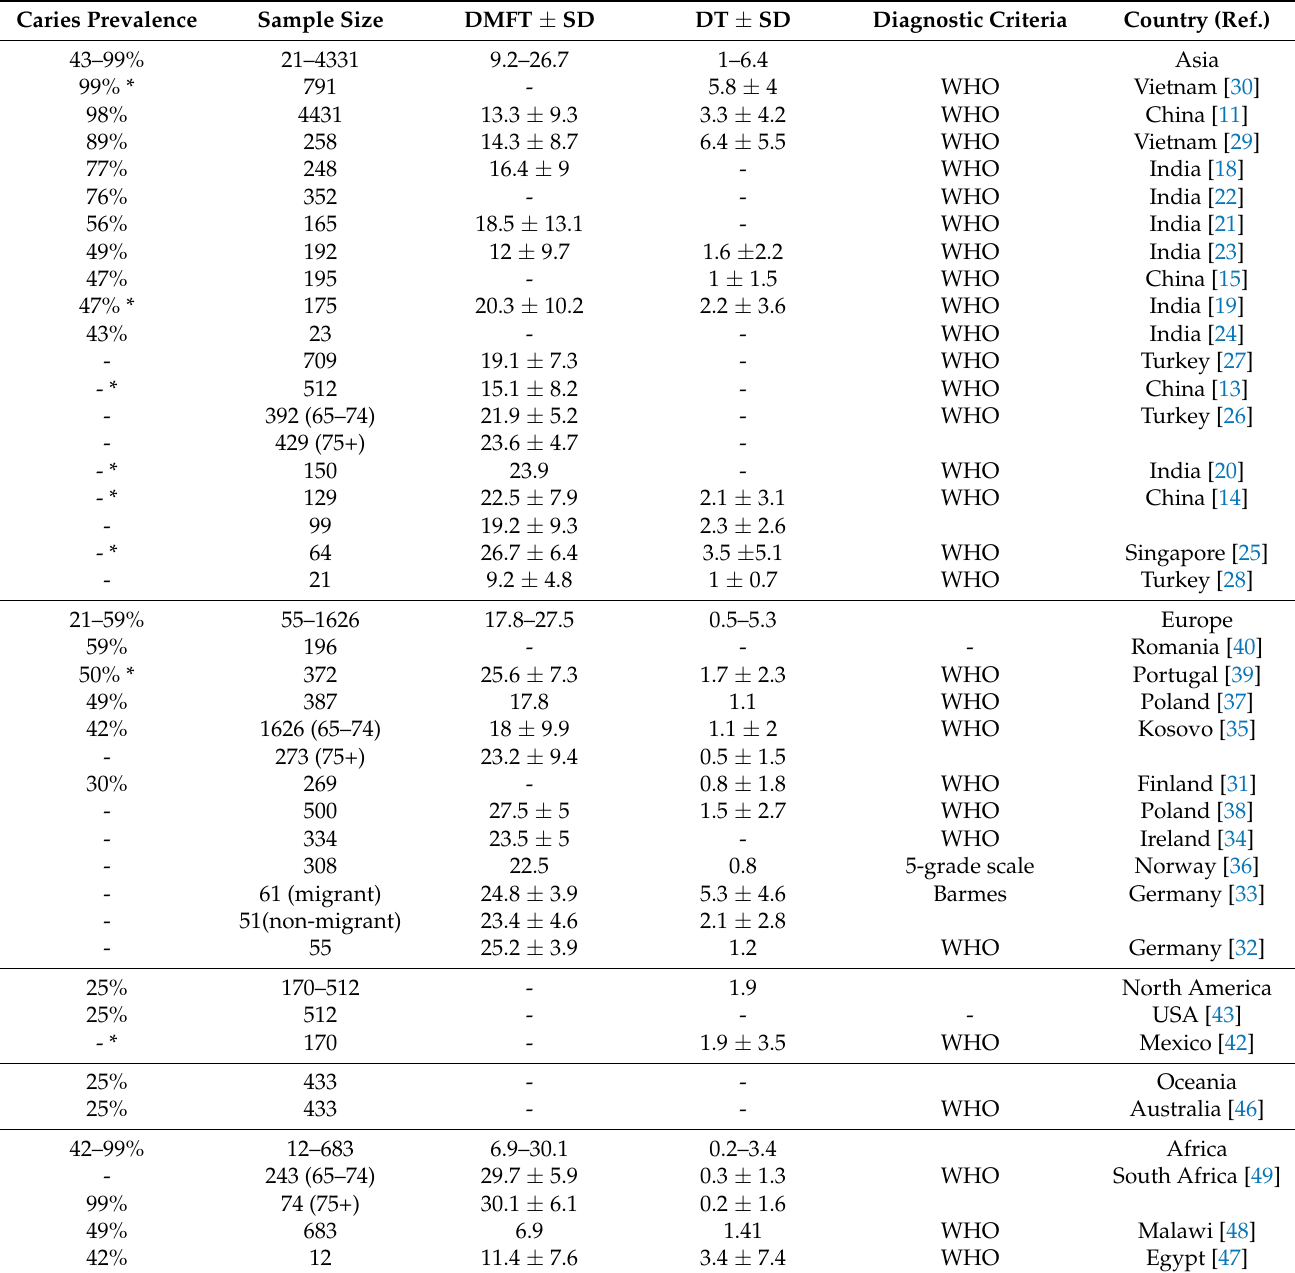
Table 3. Summary of the included studies reported on dental